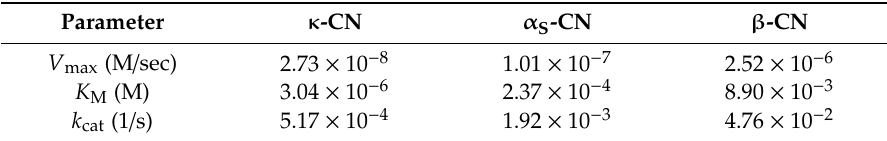
Values given are the mean of three